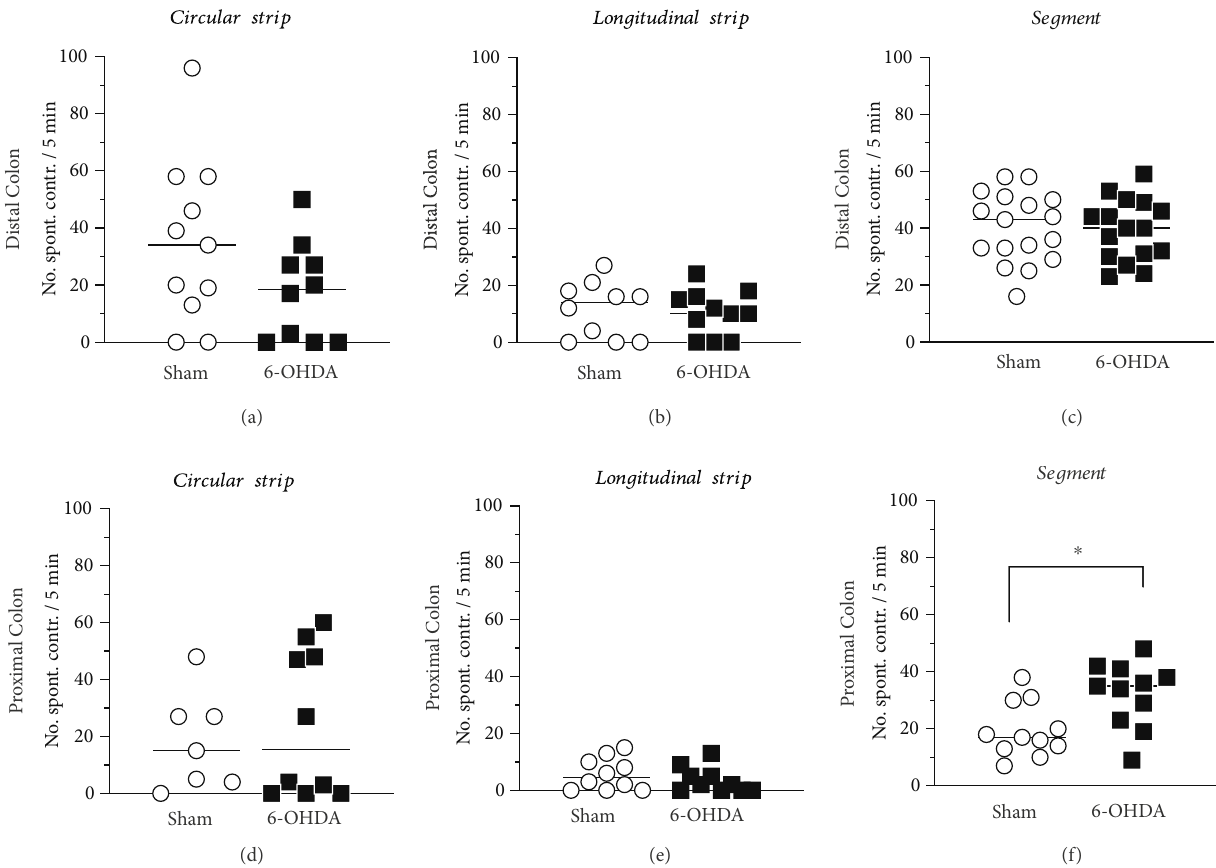
Figure 6: Spontaneous contractions in distal and proximal colon. No changes were observed between the groups in distal colon in either circular strips (a: Sham n = 10 ; 6-OHDA, n = 11 ), longitudinal strips (b: Sham n = 10 ; 6-OHDA, n = 11 ) or segments (c: Sham n = 17 6- OHDA, n = 16 ). In the proximal colon segments (f) an increased spontaneous contractility after the high K + Krebs activation were observed in the 6-OHDA ( n = 11 ) as compared with Sham animals ( n = 11 ). This was however, not observed in either circular (d: Sham n = 7 , 6-OHDA, n = 10 ), or longitudinal strips (e: Sham n = 10 ; 6-OHDA, n = 10 ) of the proximal colon. *=Signi fi cant di ff erence from Sham group; Mann – Whitney U test (f) p = 0 : 0133